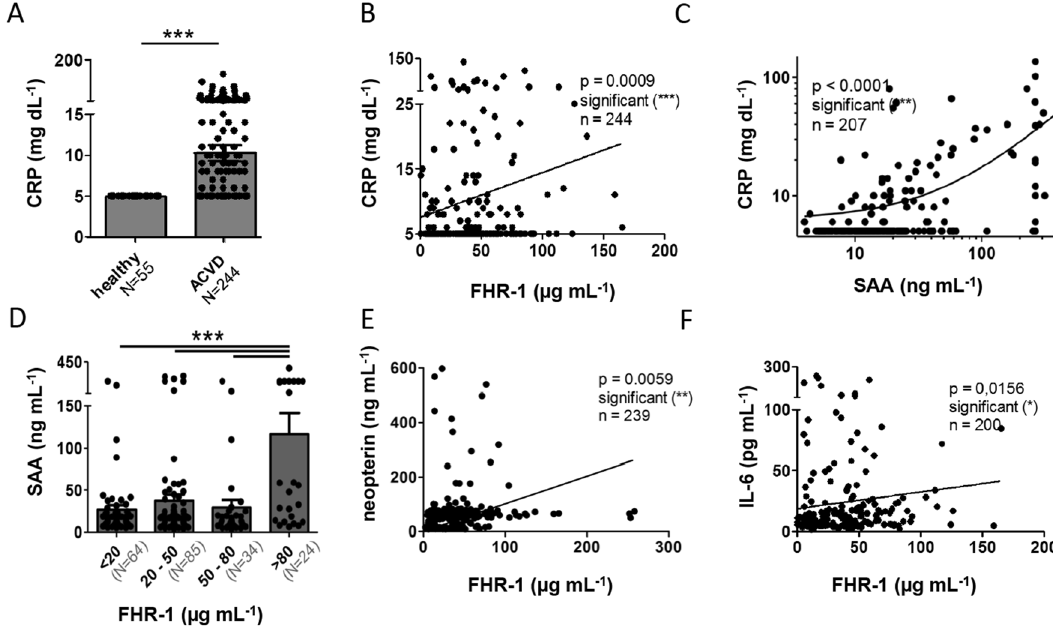
Figure 4. Elevated serum FHR-1 concentrations in ACVD patients correlate with inflammation markers. (A) C-reactive protein (CRP) concentrations were significantly higher in ACVD patients than in healthy controls (mean ± SEM, unpaired two-tailed t-test). (B) Correlations of FHR-1 concentrations with CRP concentrations and of (C) SAA concentrations with CRP concentrations. (H) ACVD patients with high FHR-1 levels (> 80 µg mL −1 ) show elevated SAA concentrations (mean ± SEM, unpaired two-tailed t-test), which correlate with (I) neopterin and (J) IL-6 concentrations. Data in (B,C,I,J) represent Spearman’s